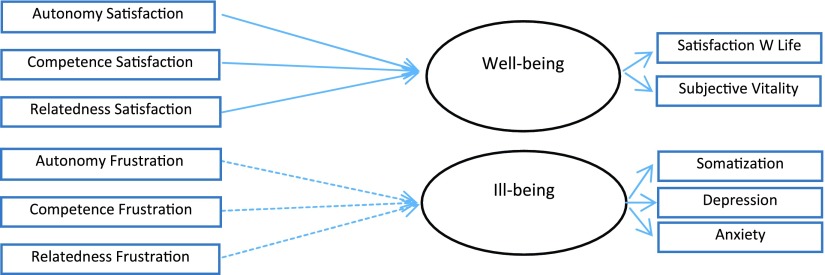
Model Overview. SEM Model 3 to 5. Note: Solid line: Model 3; Dotted line: Model 4. Model 5 specifies the six predictors simultaneously.